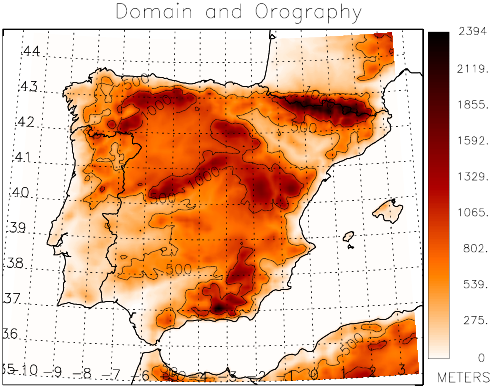
Fig. 1. Geographic domain and Fig. 1 Geographic domain and orography.